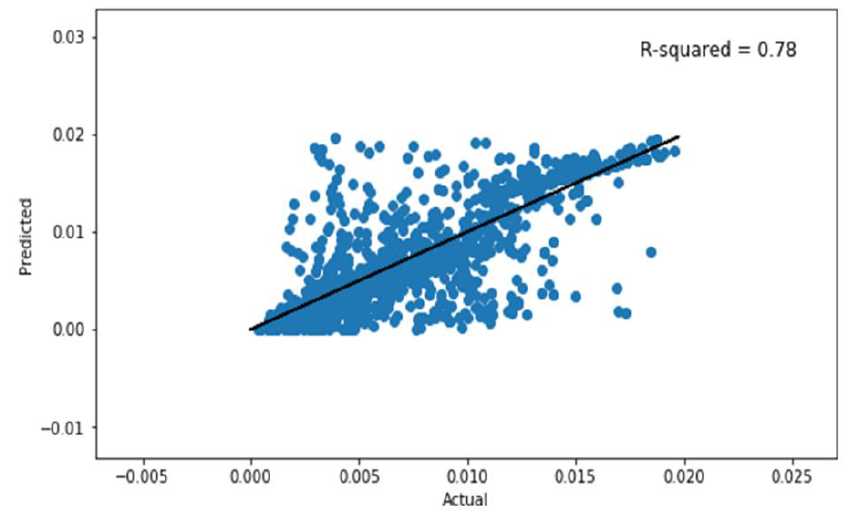
Figure 5. Comparison of instantaneous fuel for the predicted data and the actual measured data.